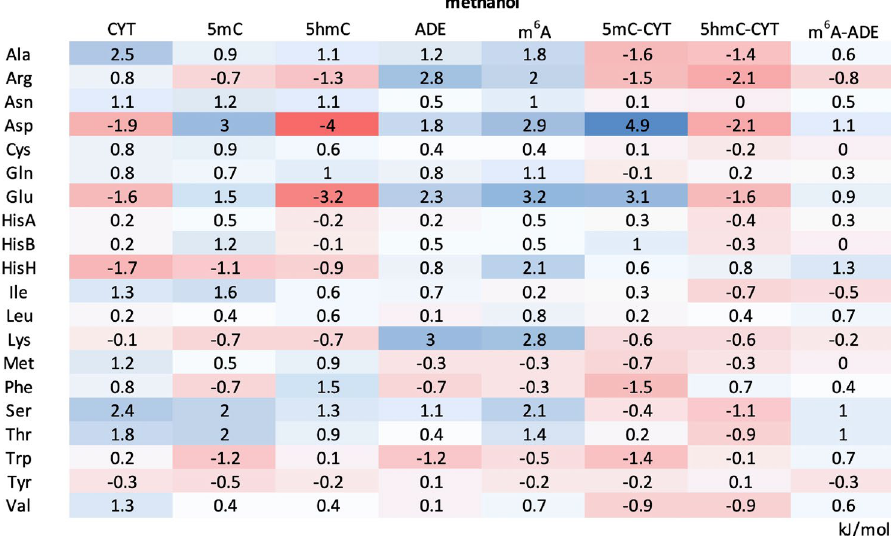
Table 2. ΔG binding in methanol between protein side chains and CYT, 5mC, 5hmC, ADE or m 6 A, together with ΔΔG binding of modified nucleobases with respect to their standard counterparts. The values for CYT and ADE were taken from de Ruiter et al. 12 . All values are given in